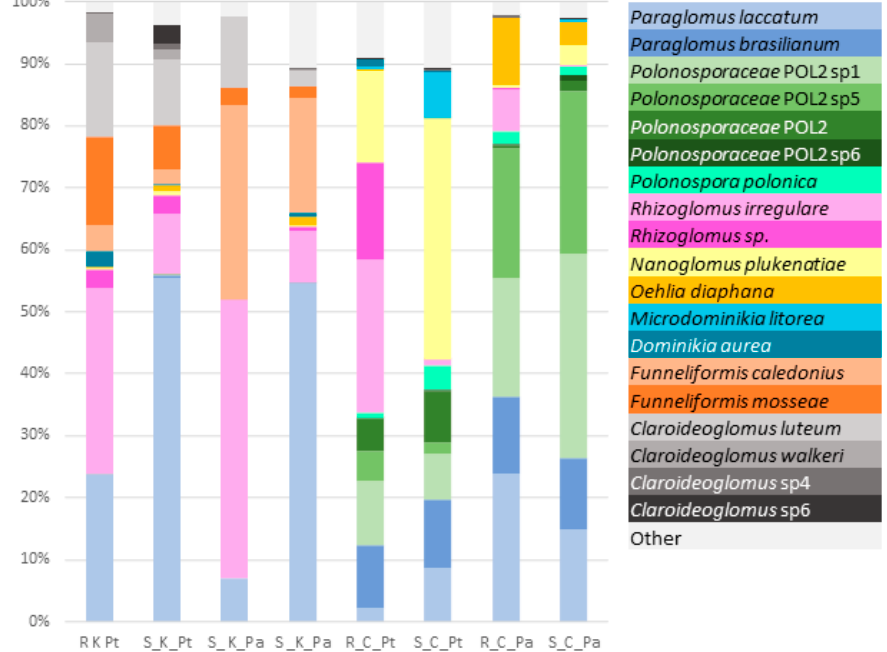
Figure 1. The percentage of relative species abundance in the root (R) and soil (S) AMF communities associated with P. trivialis (Pt) and Ph. australis (Pa) at the contaminated (K) and uncontaminated site (C).